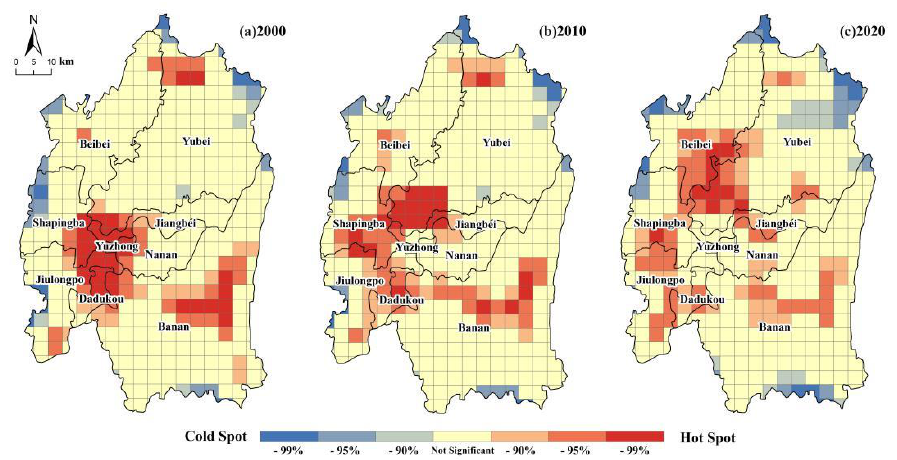
Figure 7. The cold – and hot – spot analysis of LUCs in the study area .